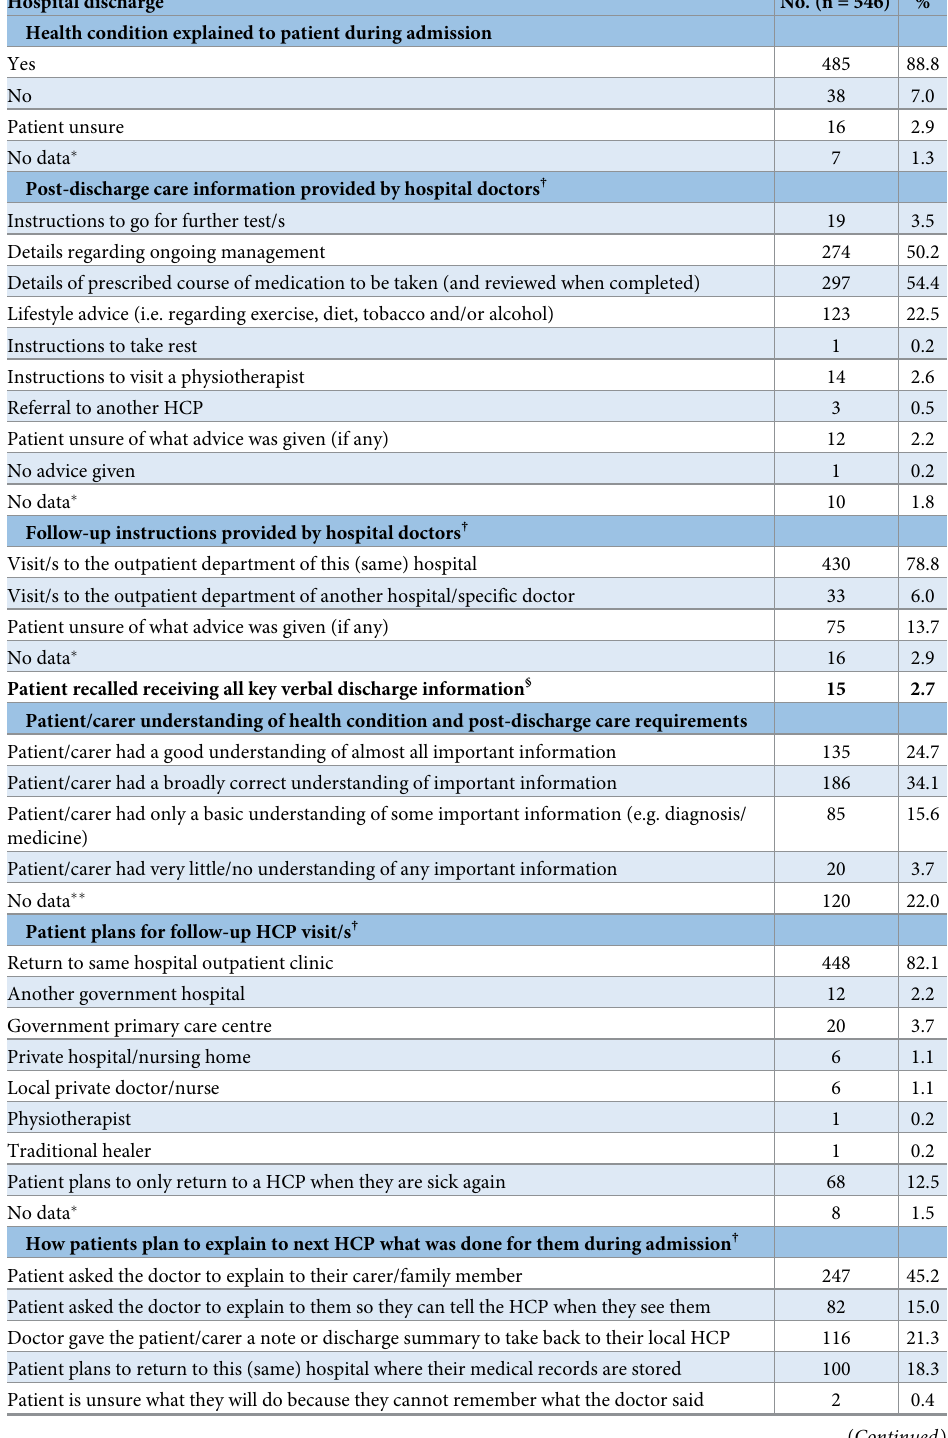
Table 2. Patient recall of verbal discharge communication and follow-up